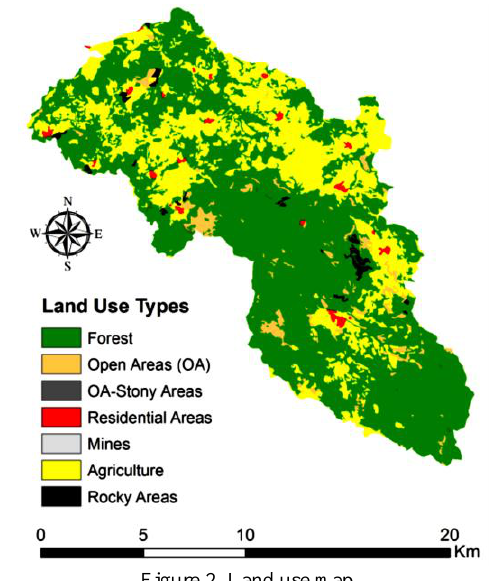
Figure 2. Land use map The forest cover map was used to generate data layers for vegetation structures. There were total of 21 tree species or species compositions in the study area. Table 2 indicates tree species compositions and their stand type codes.